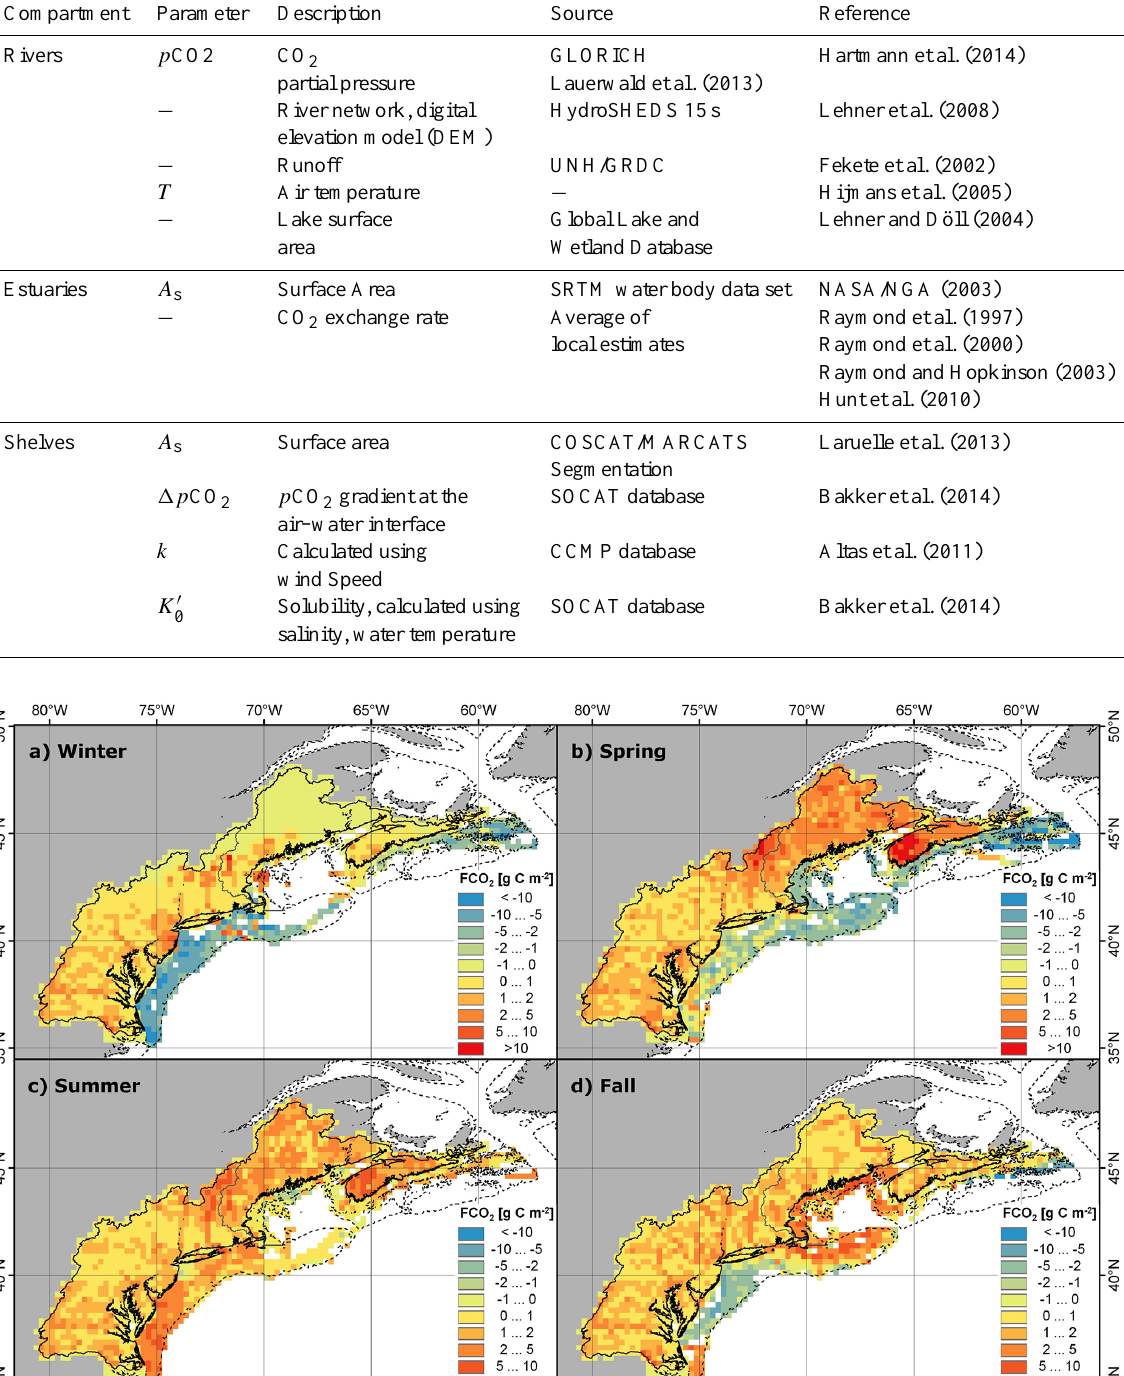
Table 1. Summary of the data used for the F CO 2 calculations in compartment of the LOAC.